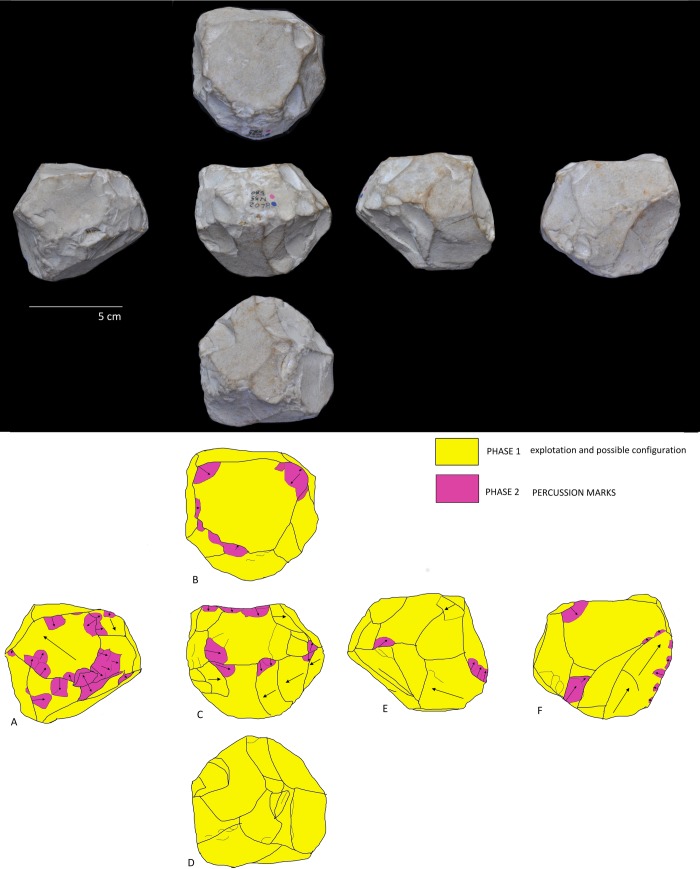
Photo and diacritical drawing of Tool C.Phase 1 (indicated in yellow): A single phase of core management (or possibly configuration). Phase 2 (indicated in purple): the tool’s protruding crests were used for pounding activity.